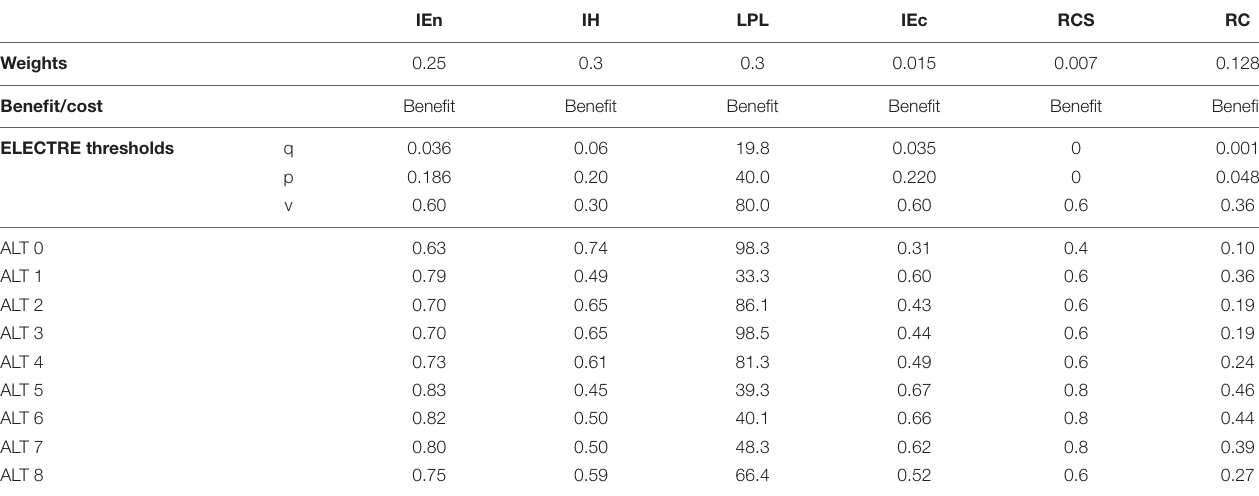
TABLE 3 | Decision matrix of the Graines torrent case study, including the weights, the indicator type (benefit or cost) and the thresholds required by ELECTRE III (q = indifference, p = preference, v = veto). IEn IH LPL